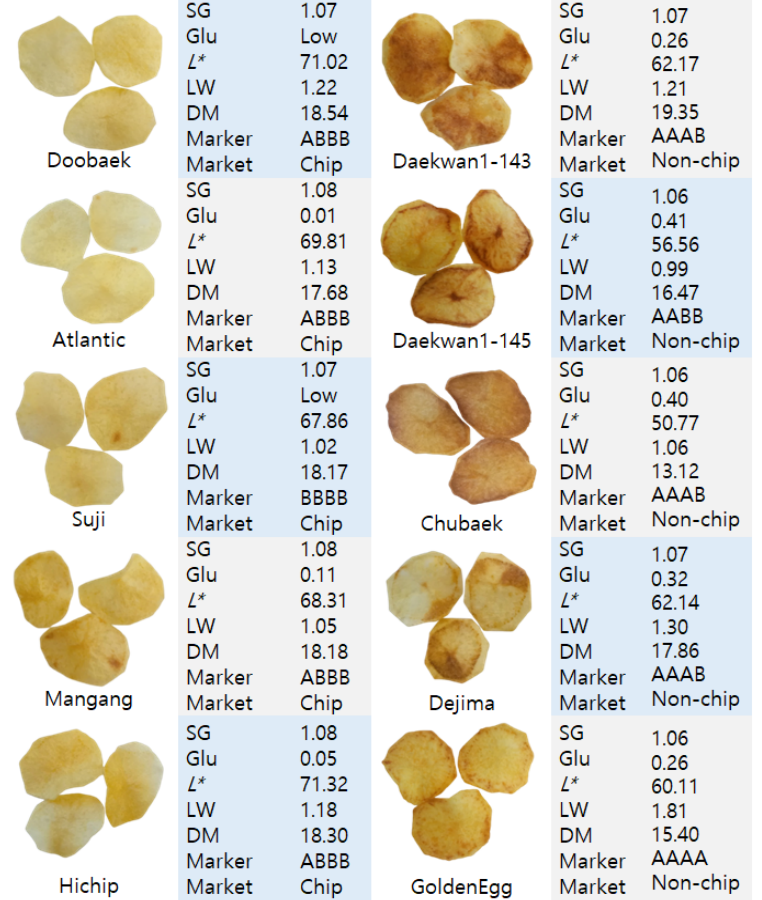
Figure 7. The genotype of KASP_c1_8019 is correlated with the chip ‐ processing market. Figure shows measurements of the respective component traits consisting of the chip ‐ processing phenotype along with their representative chip images for the selected potato cultivars. On the left are given chip ‐ processing cultivars, whereas the non ‐ chip ‐ processing cultivars are on the right. SG; specific gravity, Glu; tuber glucose concentration (grams 100 g − 1 fresh weight), L *; the lightness measurement of the potato chips, LW; the ratio of tuber length to width, DM; dry matter content, Marker; KASP_c1_8019, Low; out of detection limit, Market; chip processing or non ‐ chip processing. Traits were measured 20 days after harvest from a randomized, complete block design with two replicates in two local environments.